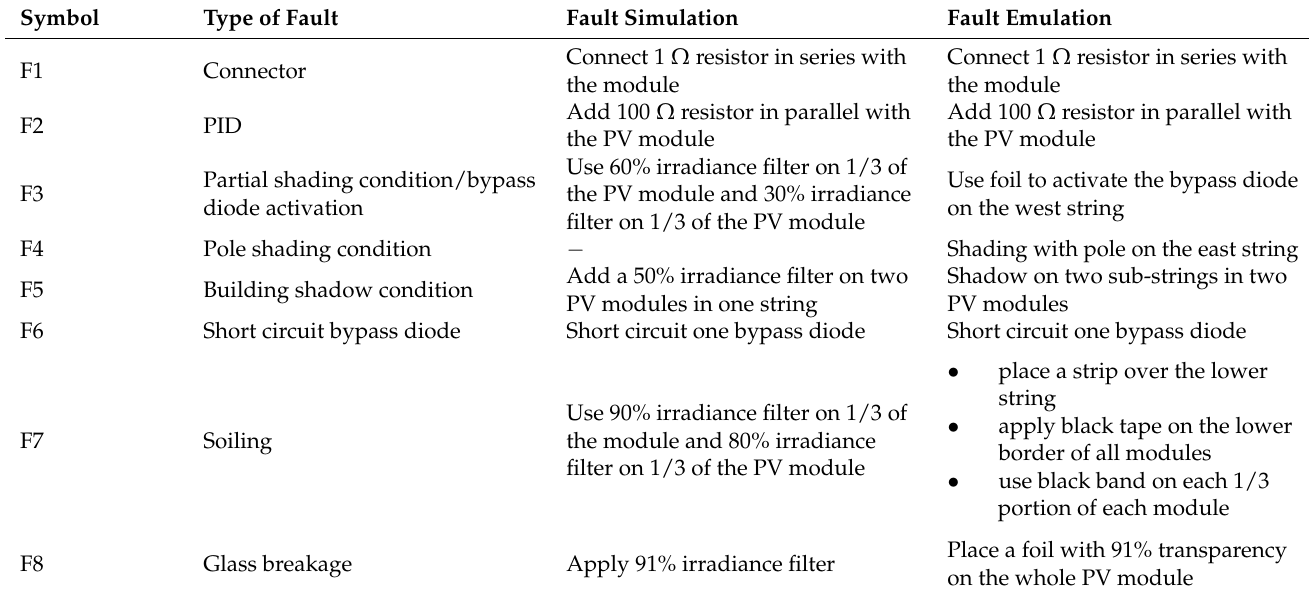
Table 5. PV module fault simulation and